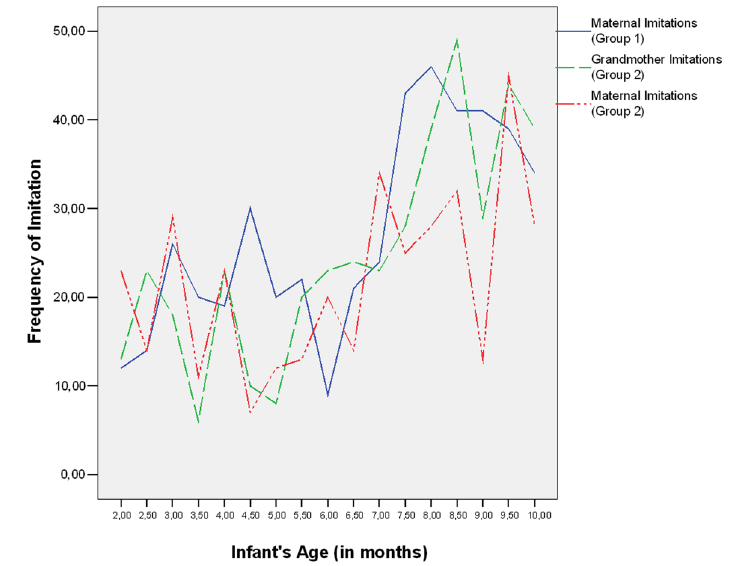
Figure 1. Developmental trajectories of maternal imitations of Group 1 and maternal and grandmother imitations of Group